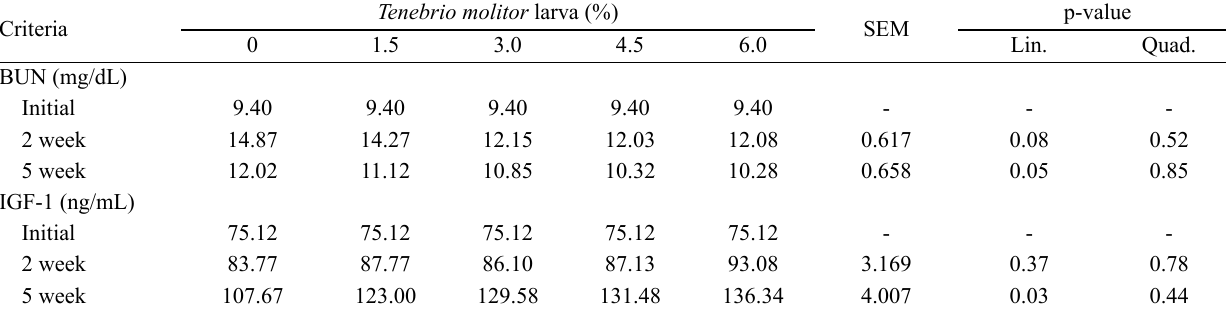
Tenebrio molitor larva (%)